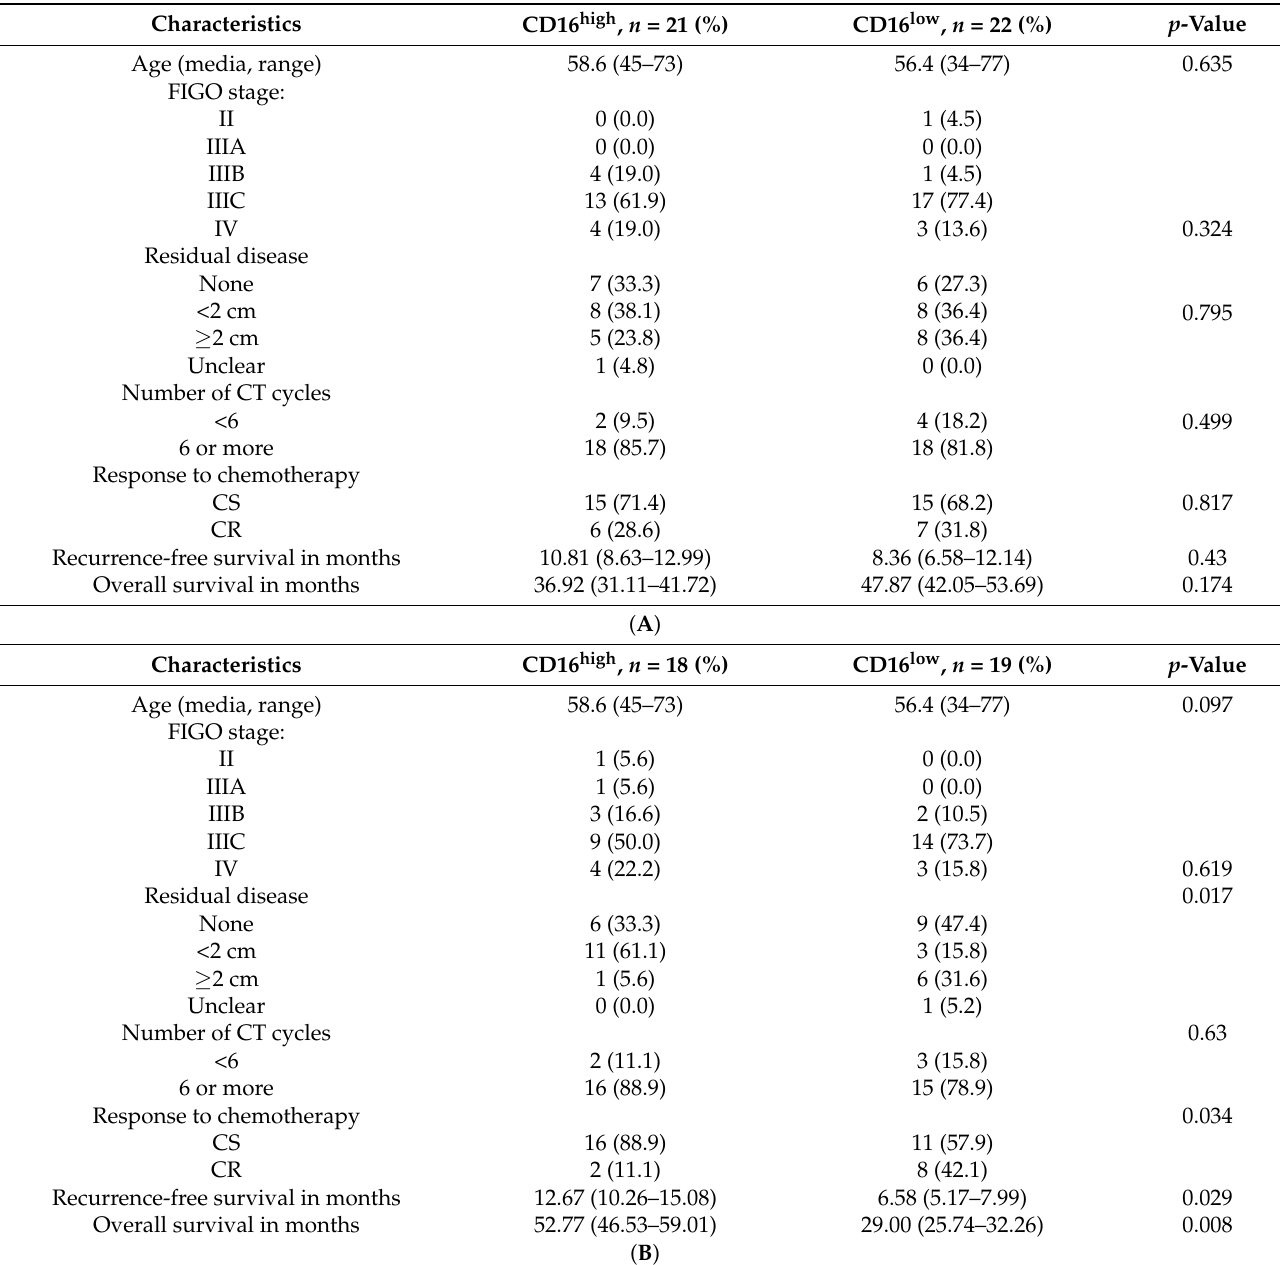
Table 2. ( A ) Patients’ characteristics according to dichotomized distribution of CD16-positive TICs in primary cancer biopsies (cut-off = 16 cells/punch, 50th percentile, n = 43 *). ( B ) Patients’ characteristics according to